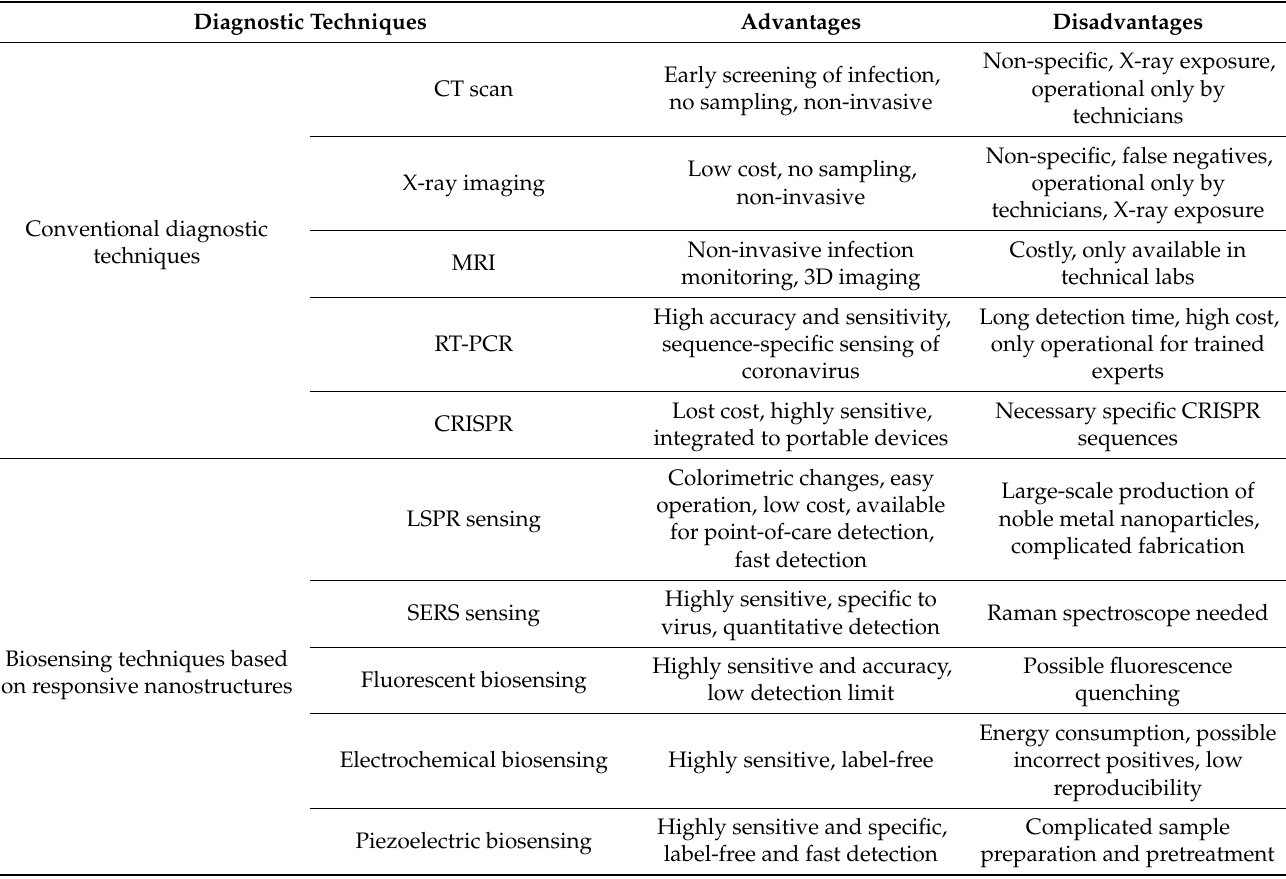
Table 1. Comparison between the conventional detection techniques and the biosensing techniques based on responsive